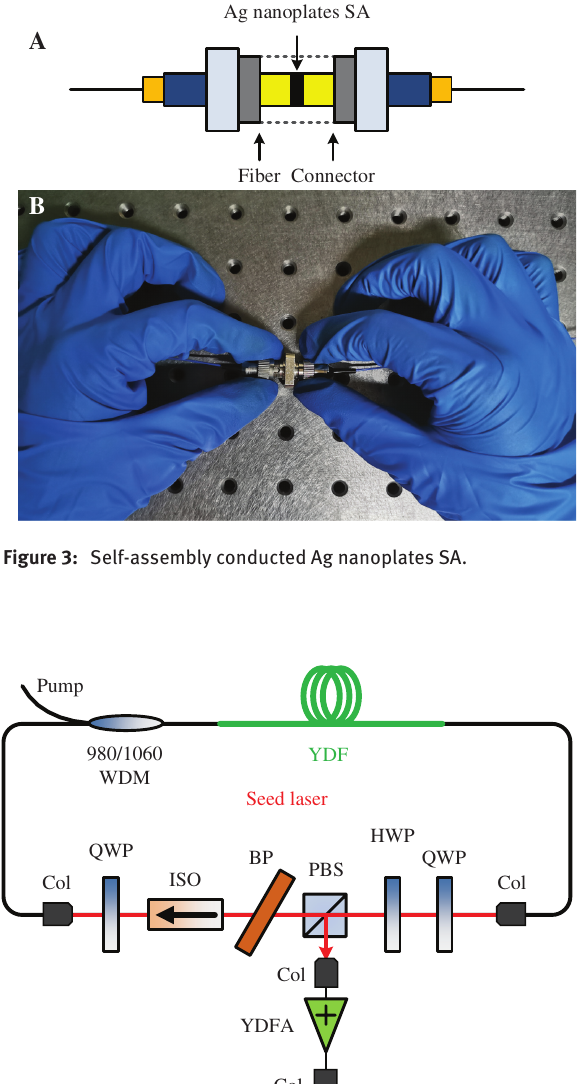
with 1000 lines/mm, the average output power of the pulse train is scaled beyond 300 mW, with pulse duration of ~ 540 fs, shown in Figure 5B.